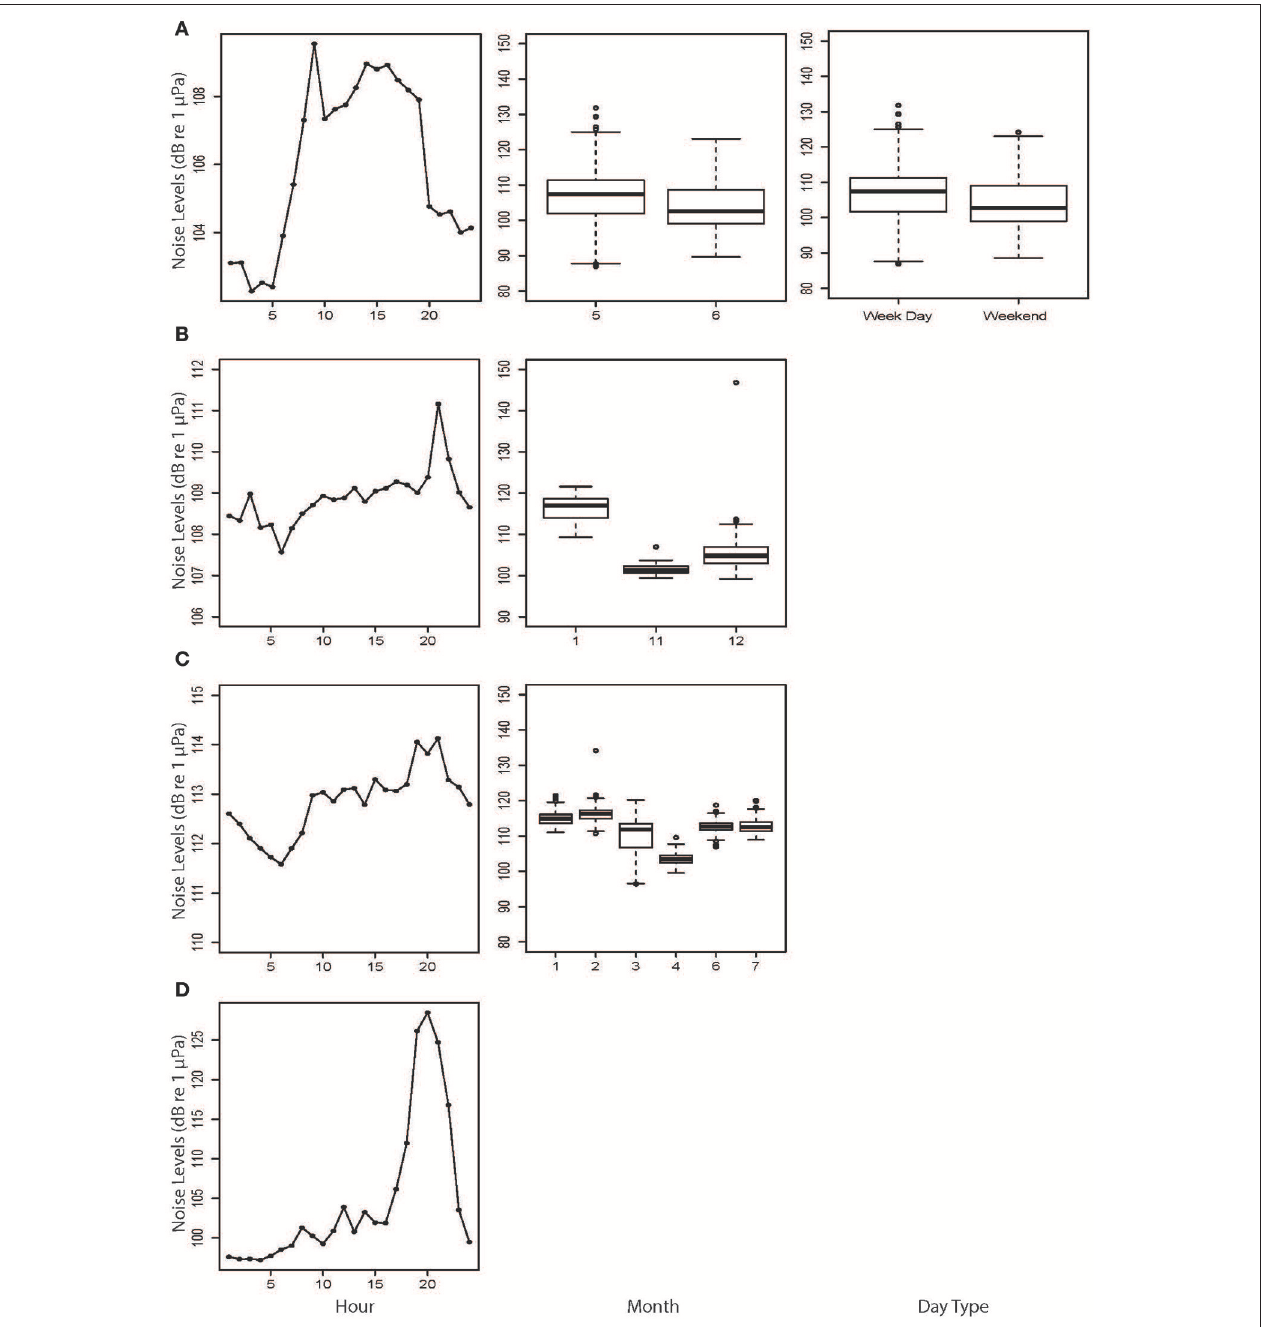
FIGURE 8 | Results from the generalized estimating equations (GEEs) based on hourly broadband noise levels from (A) Fremantle Inner Harbor, (B) Matilda Bay, (C) Perth Waters, and (D) Heirisson Island. Only significant explanatory variables are shown.